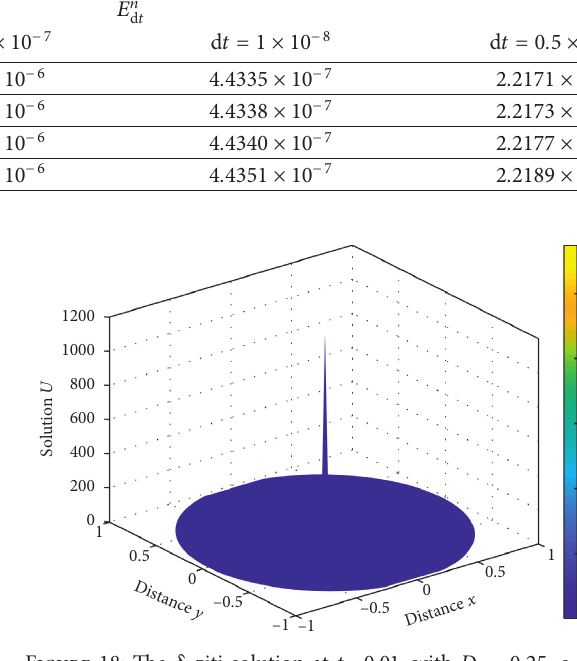
Figure 18: The δ � 0.01, with D �− 0.25, ε � 0 . 01 − ziti solution at t ( t,. )) � 780, after 345-time iterations, using the Cartesian max ( u ap